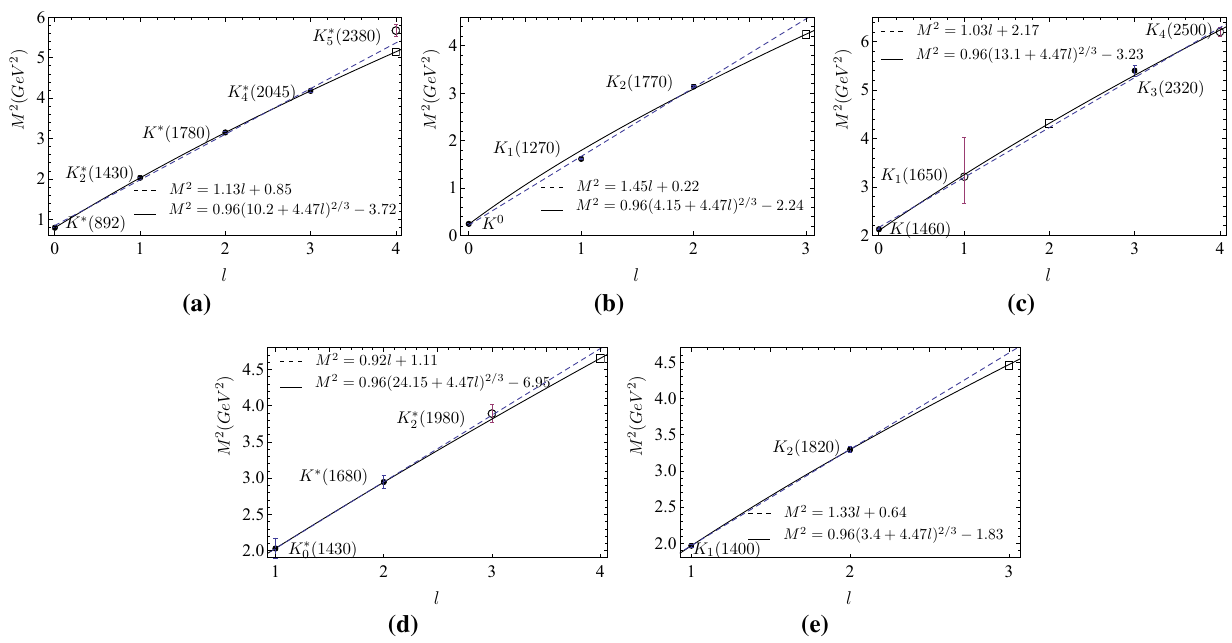
Fig. 2 Same as Fig. 1 except for the orbital Regge trajectories Table 1 Masses of the strange mesons (in MeV). The experimental data are from PDG [39]. The fitted results by using the Regge trajecto- ries [Eq. (1)] are shown in comparison with the theoretical values of GI [40], EFG [17] and PWLM [41]. ? denotes the possible candidates for